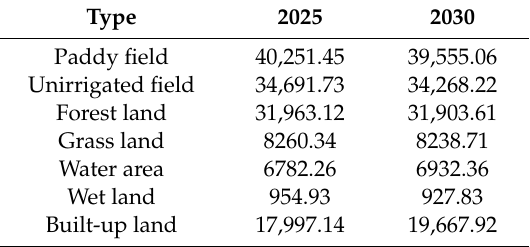
Table 11. Prediction results of land use structure in the study area for 2025 and 2030 (Unit: km 2